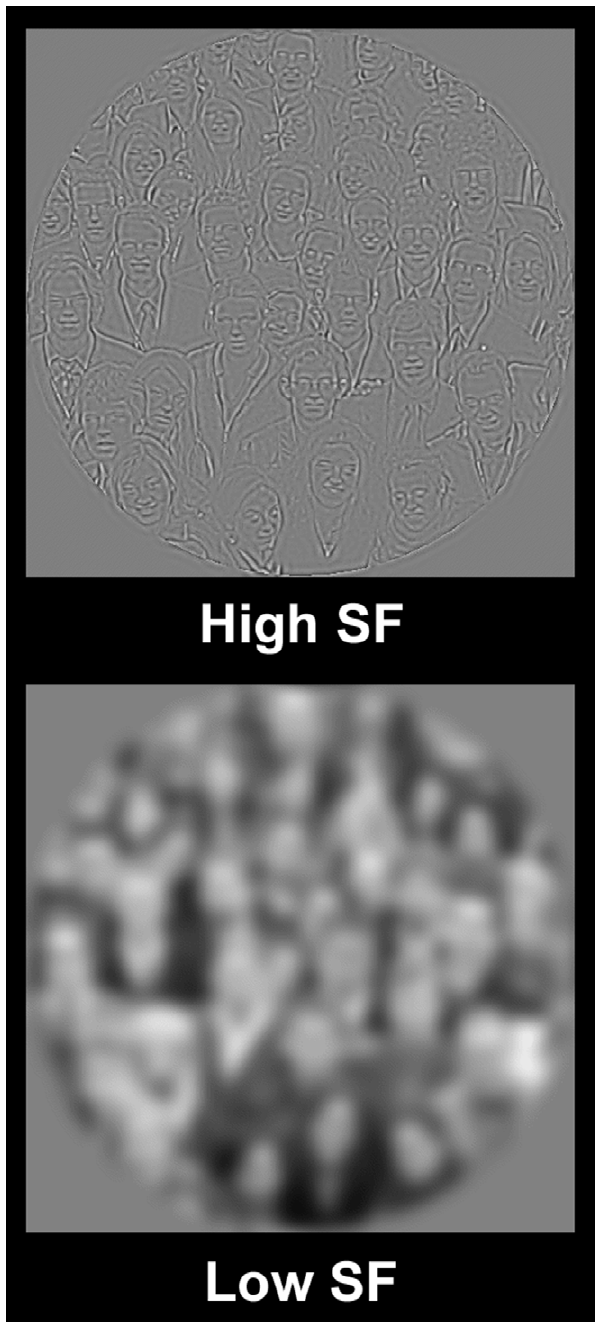
Figure 4. SF-filtered stimuli. The original stimuli were naturalistic face (and place) images (i.e., unfiltered). These stimuli were then spatially filtered using FFT to produce low SF ( , 1 c/deg), middle SF (1–5 c/deg), or high SF ( . 5 c/deg) images. For a complete set of stimuli, see http://nmr.mgh.harvard.edu/˜reza/SFstimuli.pdf.